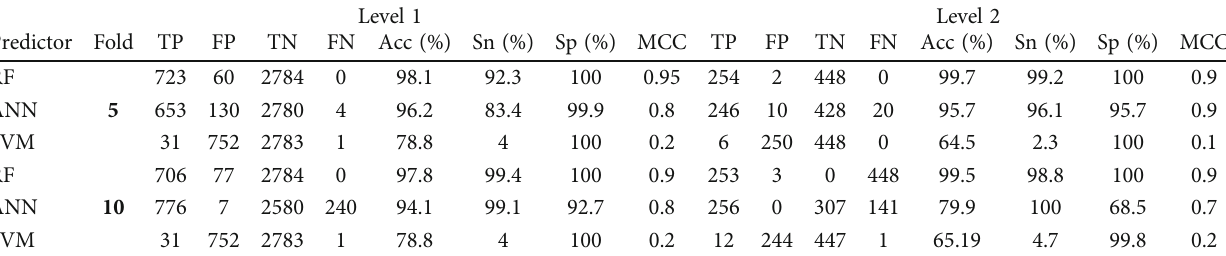
Table 3: k -fold cross-validation results.